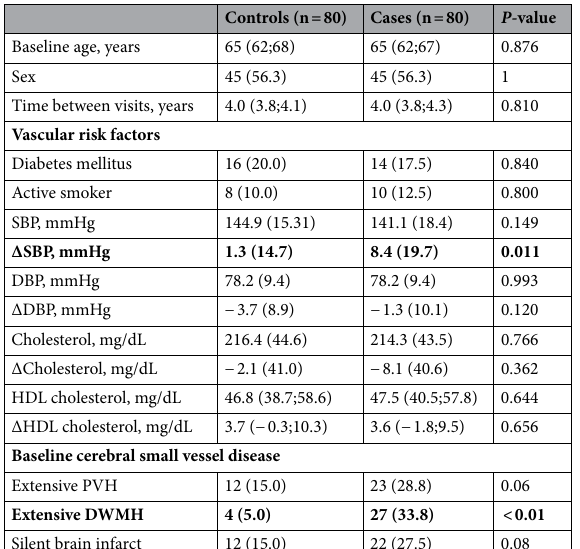
Table 1. Characteristics of the replication phase sample by cases and controls. Values represent mean (standard deviation [SD]), median (interquartile range), or number (%). Bolded variables are those which show significant differences between cases and controls ( p -value < 0.05). DBP, diastolic blood pressure; DWMH, deep white matter hyperintensities; HDL, high-density lipoprotein; PVH, periventricular hyperintensities; SBP, systolic blood